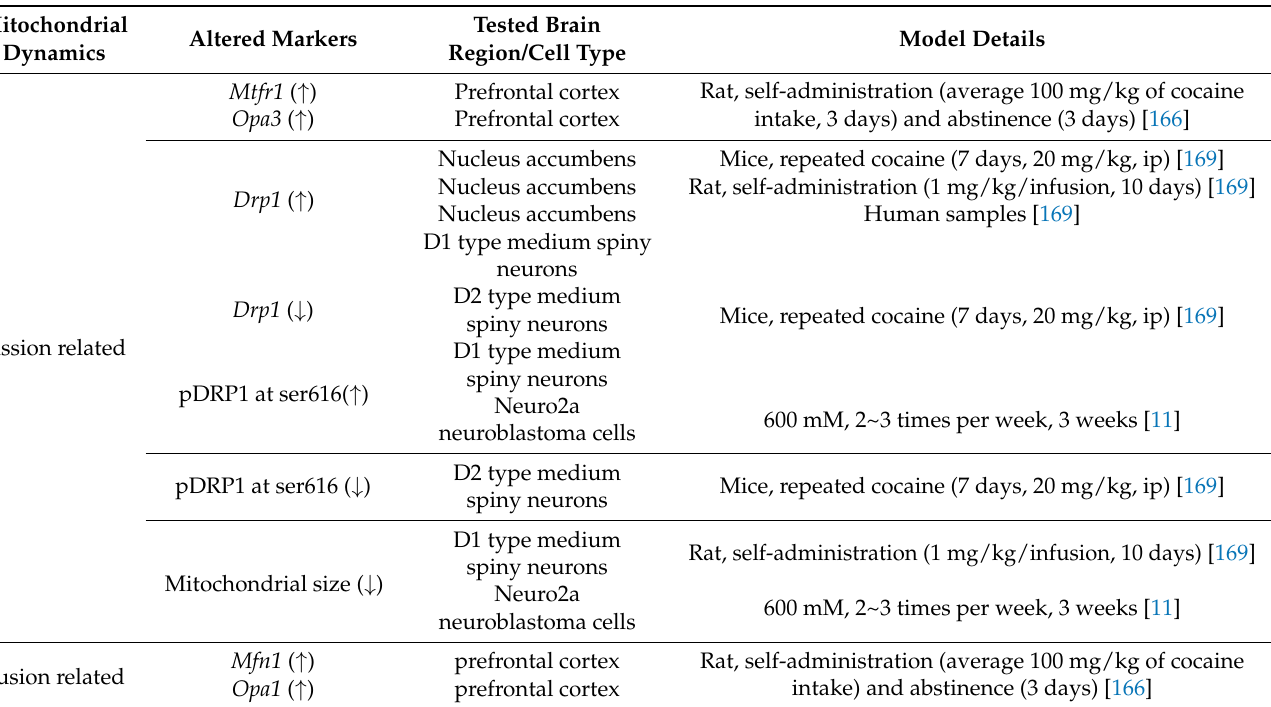
Table 1. Current findings of how cocaine affects neuronal mitochondrial